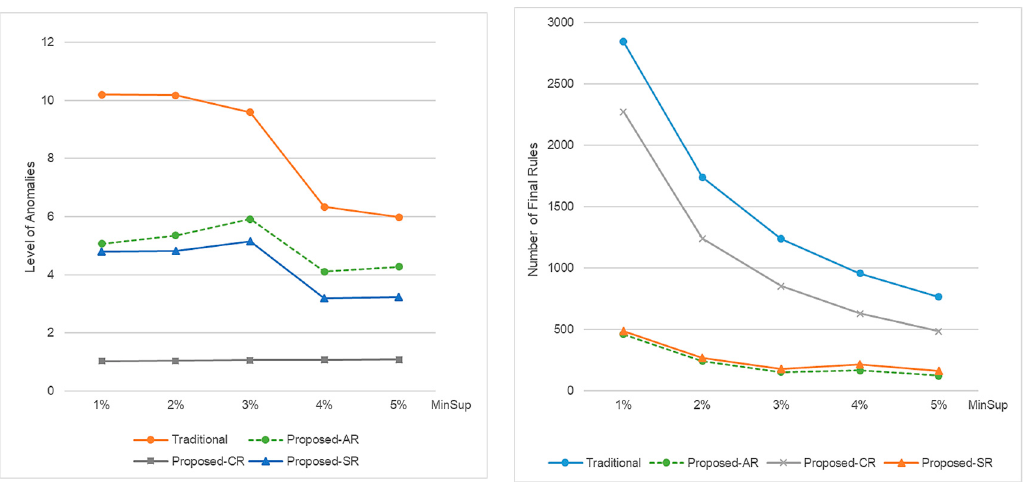
Figure 3. The performance comparison of level of anomalies ( left ) and number of final rules ( right ).